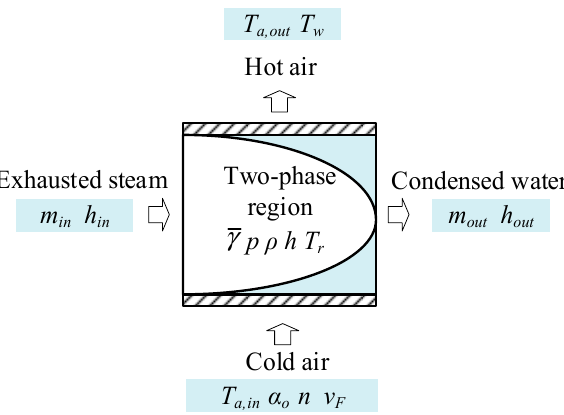
Figure 3. A schematic of the simplified air-cooling unit model. 1.